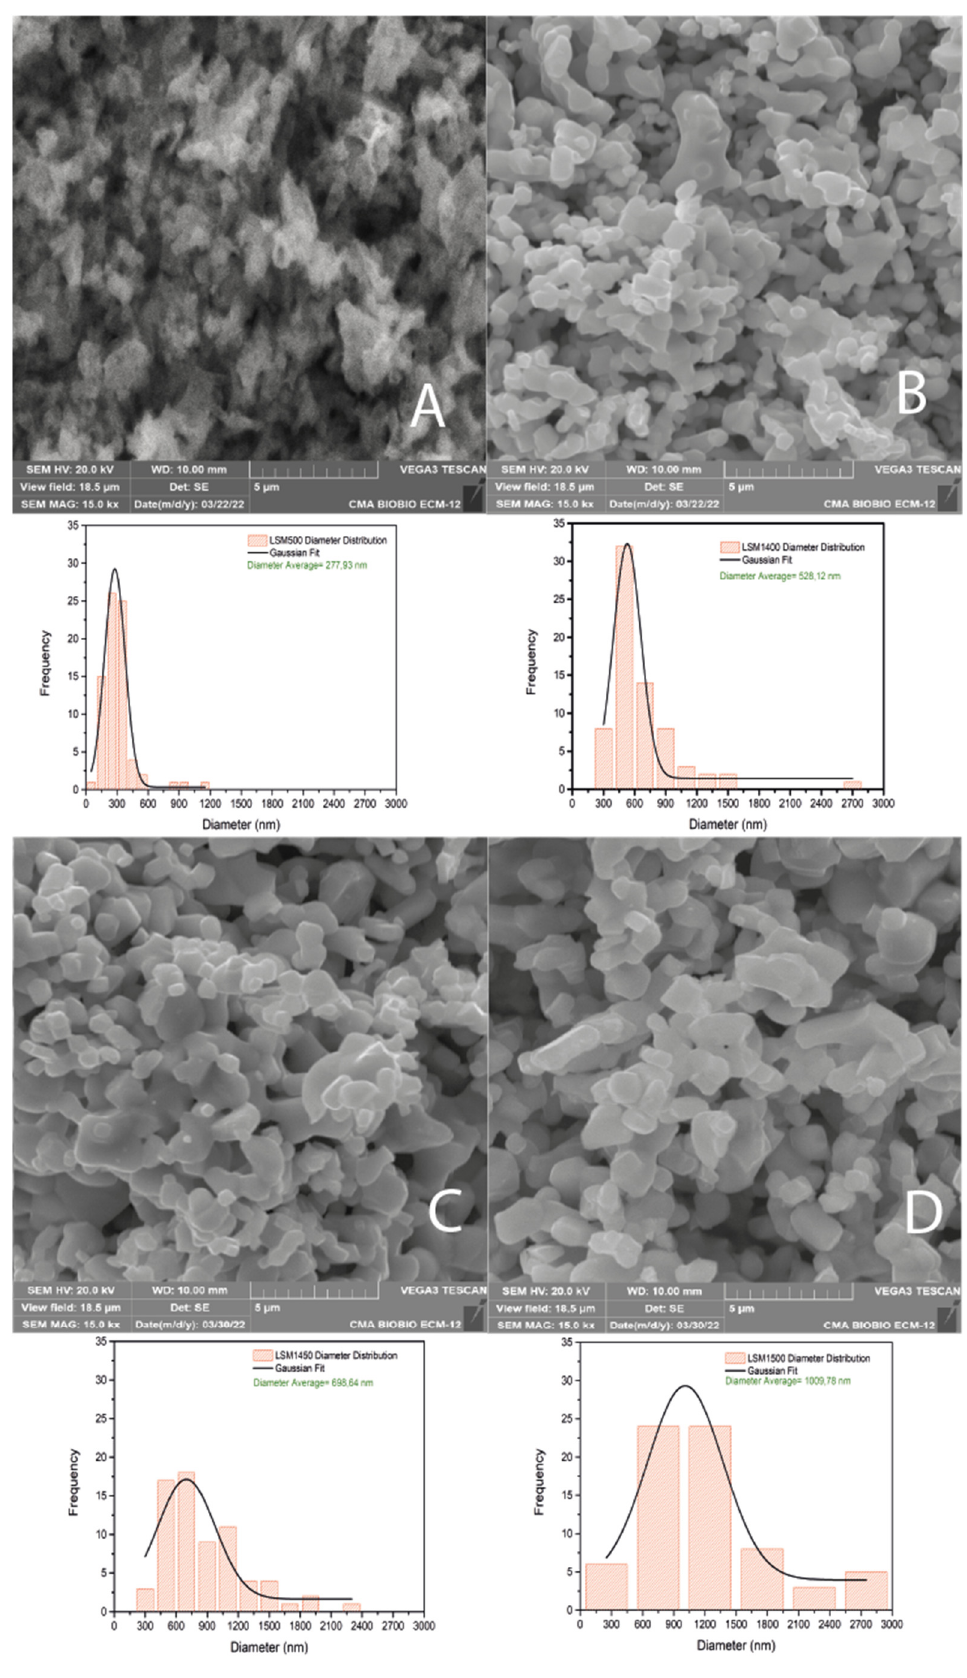
Figure 2. SEM images and corresponding grain size distribution of the combusted and calcined LSM powders: ( A ) LSM500, ( B ) LSM1400, ( C ) LSM1450, and ( D ) LSM1500.